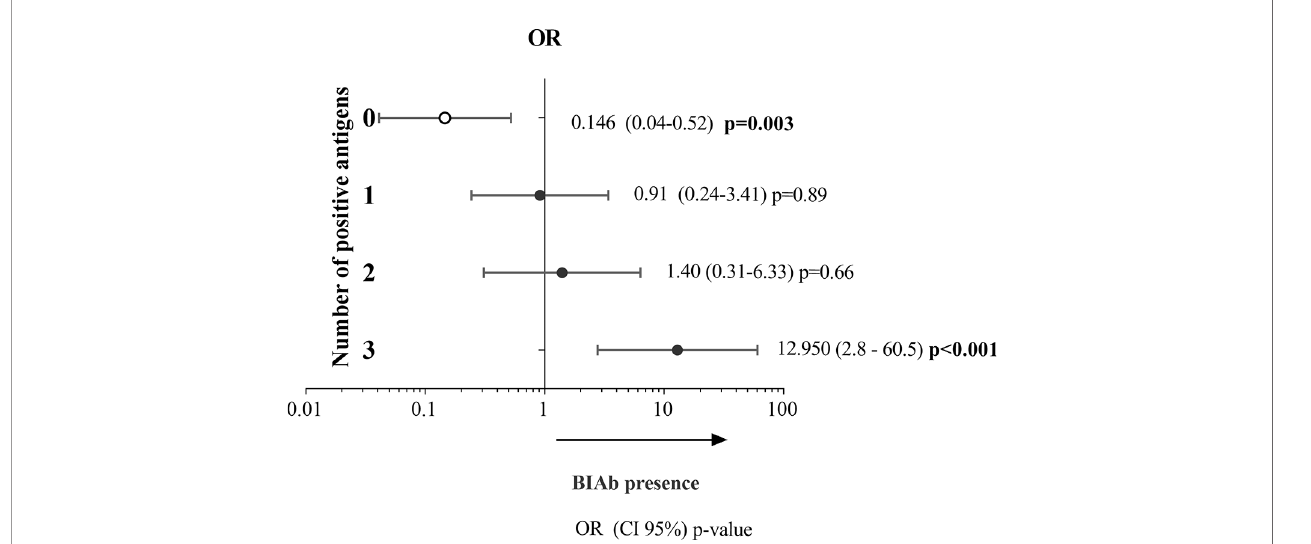
FIGURE 4 | Association between DBPII antibody response as detected in the DBPII-multiplexed microsphere-based cytometric assay and BIAbs as determined by standard COS-7 cytoadherence assay. Two-hundred and forty- fi ve plasma samples of P. vivax -exposed individuals were screened for (i) antibodies targeting DBPII- DARC interaction (BIAbs) using the COS-7 cell erythrocyte-binding assays (26) and (ii) anti-DBPII antibody responses as detected by the DBPII-based multiplex assay. The relative likelihoods of positivity in the multiplex assay corresponding to the presence of BIAbs (dependent variable used as reference) were calculated according to the number of DBPII proteins recognized in the DBPII-multiplex assay, including none (zero), one (1), two (2), or three (3). Odds ratio (OR) with respective 95% con fi dence intervals (95% CI) and p -values were determined using the logistic regression model with multiplex seropositivity against none, one, two, or three recombinant proteins used as confounding